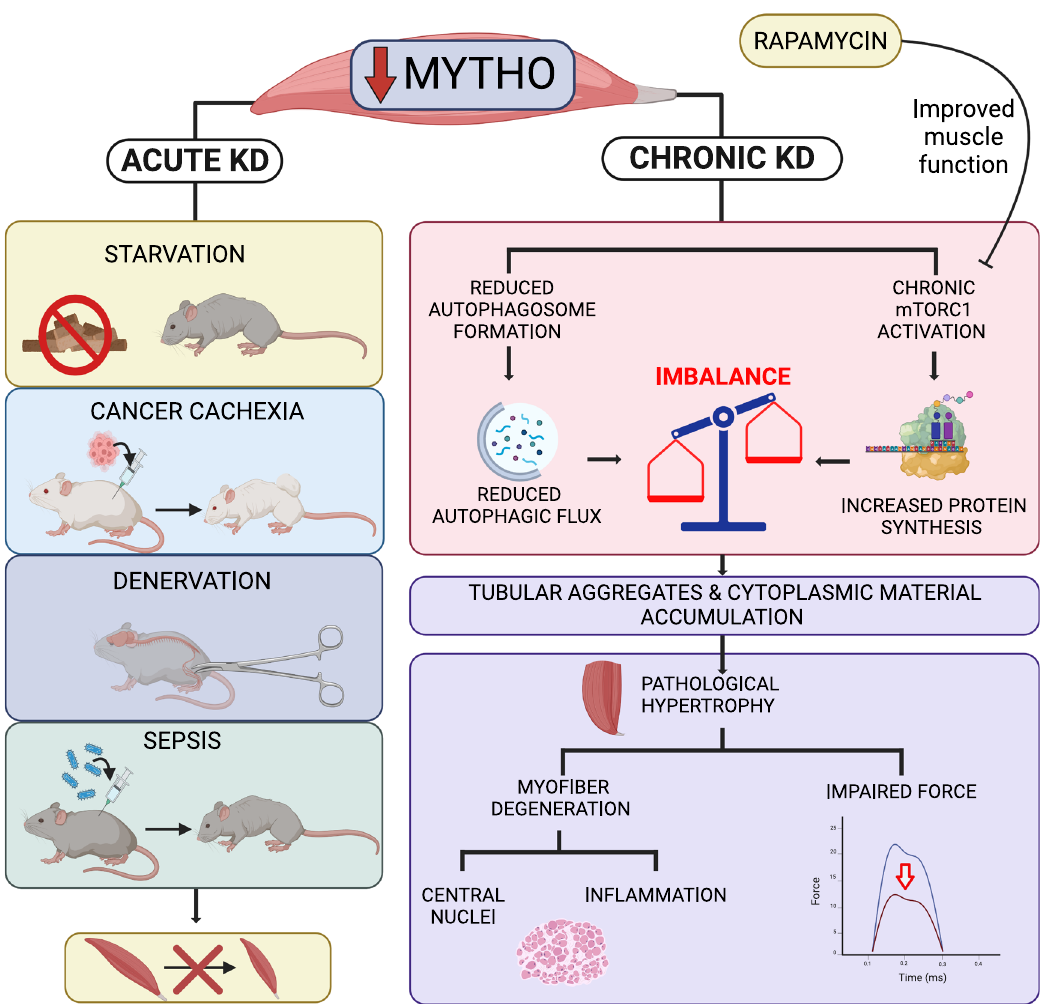
Fig. 8 | Mytho : a novel gene involved in the regulation of autophagy, skeletal muscle mass, and integrity. Scheme illustrating the role of MYTHO in skeletal muscle homeostasis. Acute MYTHO depletion protects from atrophy in different catabolic conditions (starvation, cancer cachexia, denervation, and sepsis). Pro- longed MYTHO depletion in skeletal muscle blunts autophagic fl ux and triggers